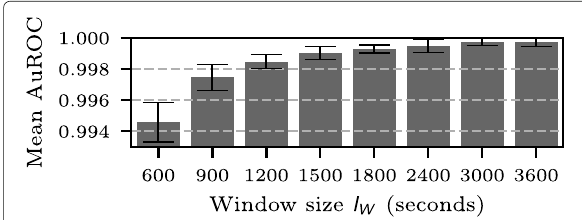
Fig. 6 Detection performance as a function of window size l W Fig. 7 Detection performance on novel mining